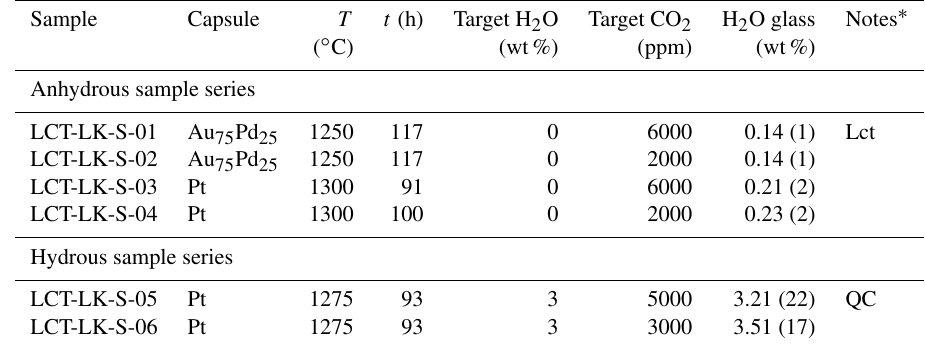
Table 2. Experimental conditions and results of synthesis experiments.